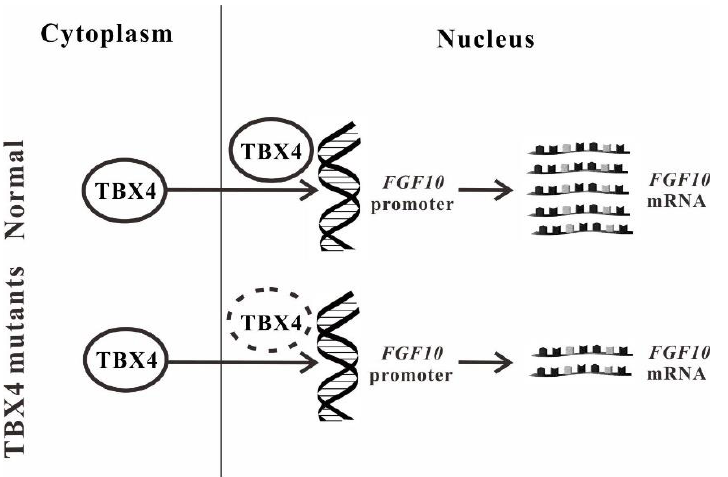
Figure 5. Schematic diagram of TBX4 mutations resulting in small patella syndrome (SPS). Arrows indicate that TBX4 mutations do not alter the translocation of TBX4 into the nucleus. The dashed oval indicates the reduced binding efficiency of TBX4 mutants with the FGF10 promoter.